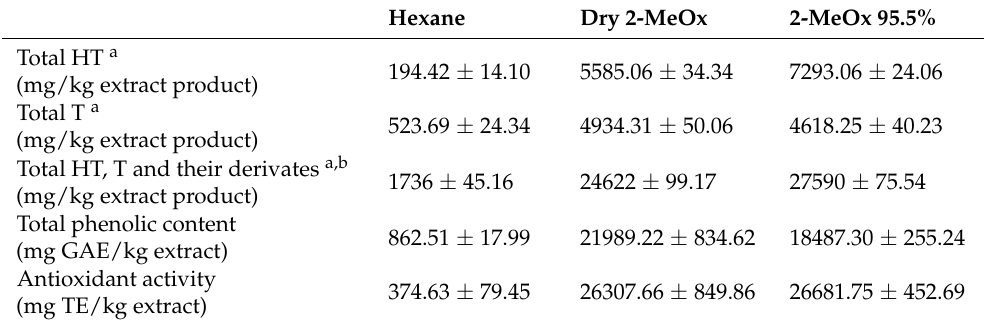
Table 6. Determination of total amount of HT, T and their derivatives, after hydrolysis of extracts products, and total phenolic content and antioxidant activity of